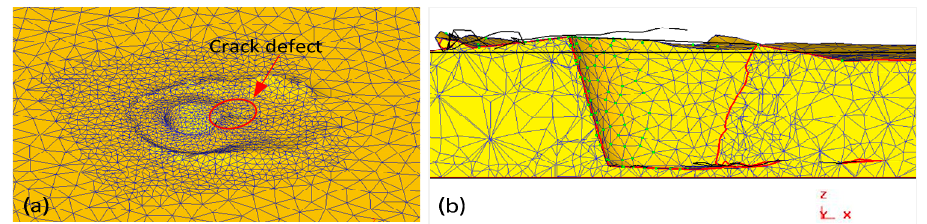
Figure 18. Simulation of the formation of weld defects. ( a ) Crack defects; and ( b ) hole